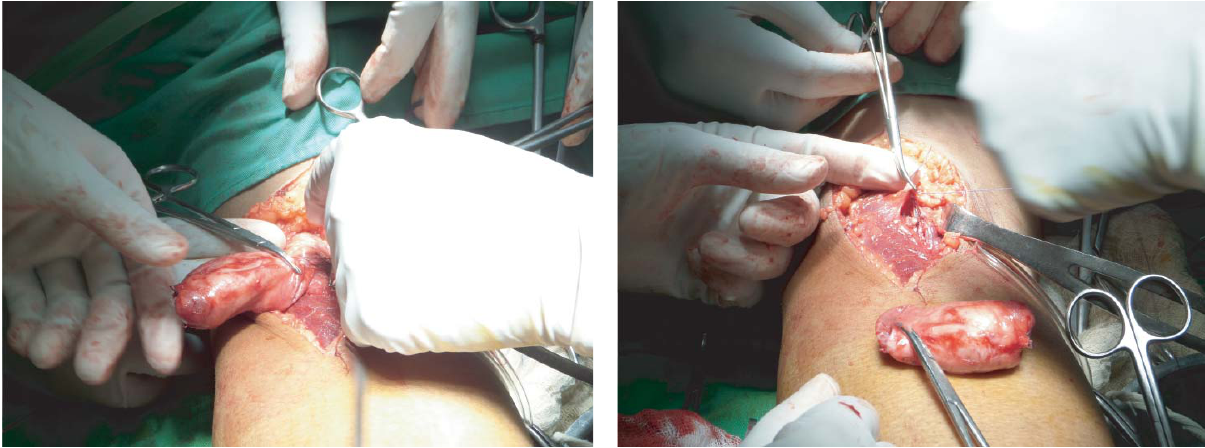
Fig 2. Per-operative pictures of the lump resection